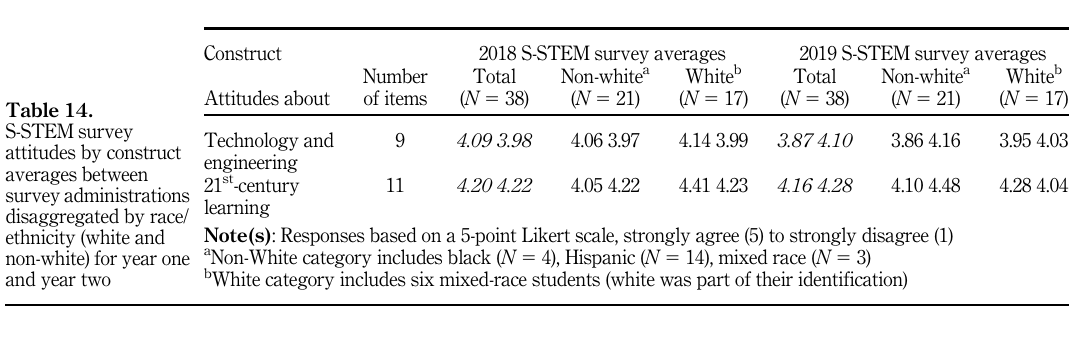
Table 15. S-STEM survey attitudes by construct averages between survey administrations disaggregated by grade levels (6th-7th grades and 8th grade) for year one and year two